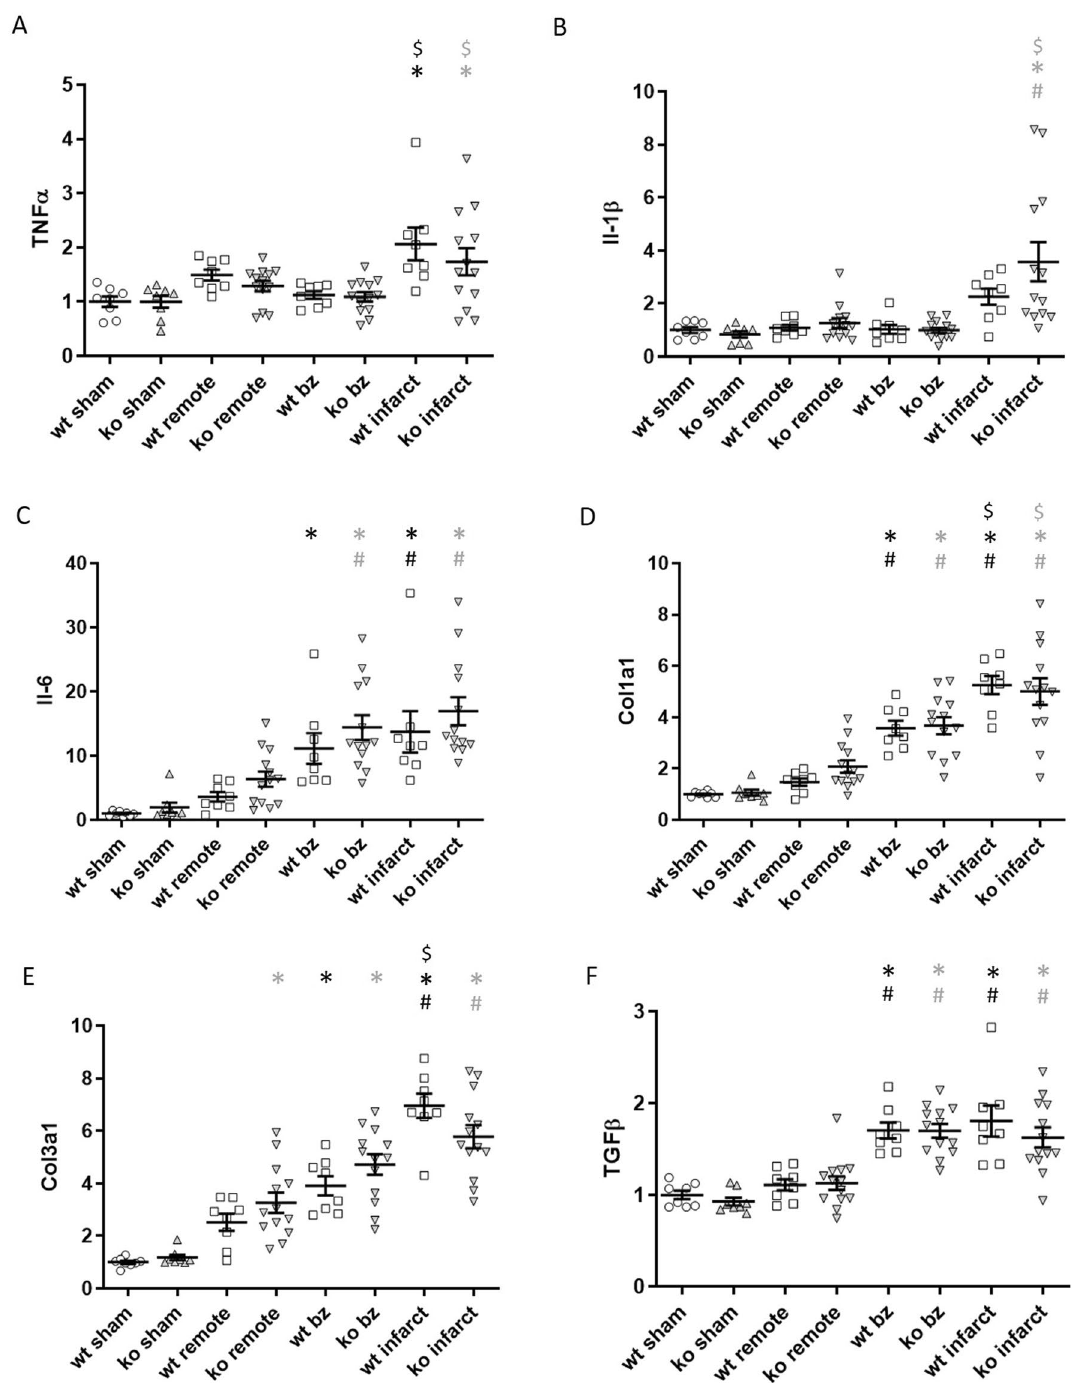
Figure 6. PMCA 4 global deletion does not affect chronic inflammation or fibrosis 6 weeks post MI. Regional gene expression was examined by qRT-PCR in WT (clear points) and PMCA4 −/− (grey points) hearts 6 weeks post sham or MI surgery for pro-inflammatory cytokines ( A ) TNFα, ( B ) Interleukin-1β and ( C ) Interleukin-6, in addition to fibrosis markers ( D ) Col1a1, ( E ) Col3a1 and F) TGFβ. bz = infarct border zone. Shams n = 8, WT MI n = 8, PMCA4 −/− MI n = 13. * p < 0.05 versus sham, # p < 0.05 versus remote, $ p < 0.05 versus border